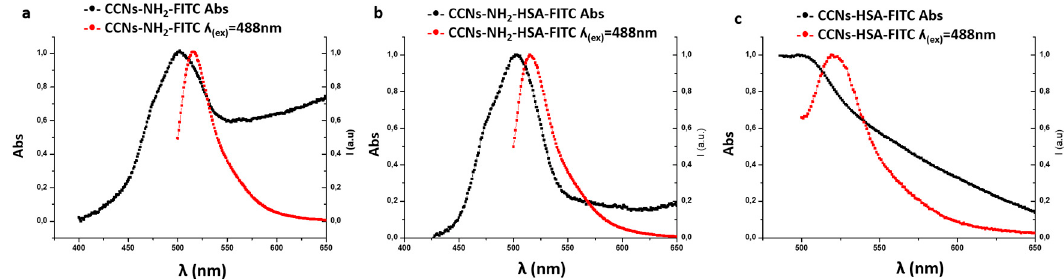
Figure 3. Absorbance and emission spectra of CCNs-NH 2 -FITC ( a ), CCNs-NH 2 -FITC-HSA ( b ) and CCNs-HSA-FITC ( c ).